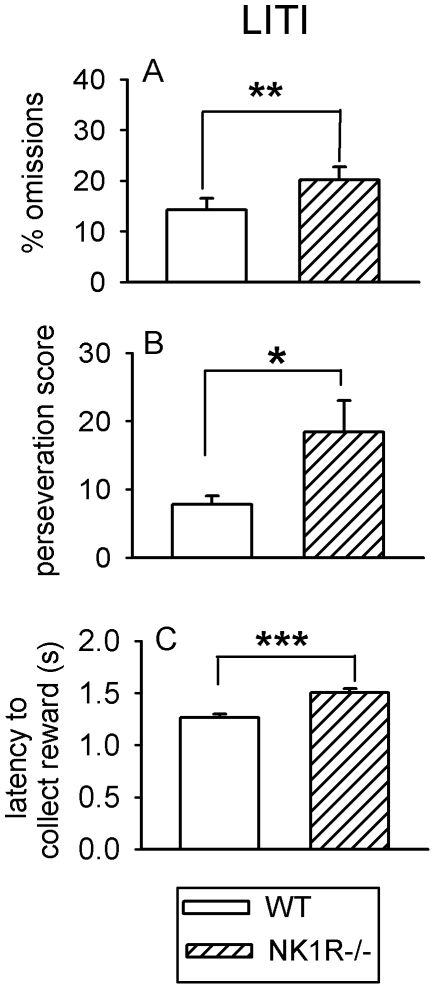
The performance of wildtype and NK1R-/- mice tested with a long ITI (‘LITI’) in the 5-CSRTT.
% Omissions (A), perseveration score (B) and latency to collect the reward (C) are all greater in NK1R-/- mice than wildtypes, regardless of time of day, when tested with a long inter-trial interval (LITI). Bars show mean ± s.e.m score for each behavior. N = 23–24 per group. * P<0.05, ** P<0.01, *** P<0.001.